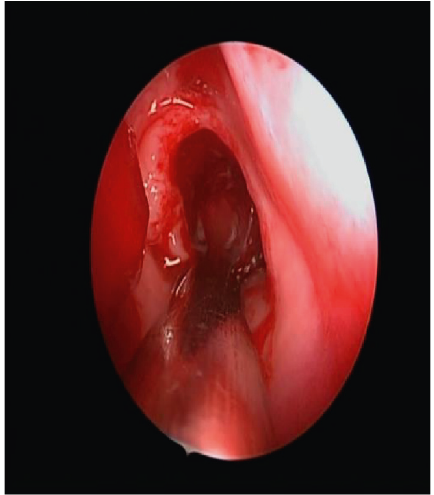
Figure 6: Post debulking and drilling of the